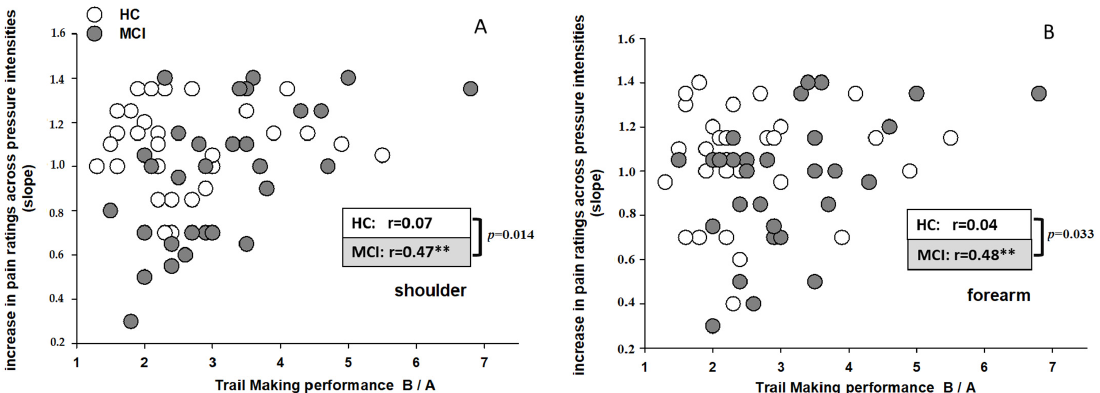
Figure 2. Associations between the escalation in pain perception across pressure stimuli (slope) and executive functioning (TMT-B/A) for the two stimulation sites ( A ). shoulder; ( B ). forearm). The different groups (HC, MCI) are displayed in different shades of grey. Partial correlation coefficients (r-values) are displayed separately for each group. Significant r-values are specified by ** ( p < 0.01). The p -values refer to the comparison of correlation coefficients between groups using z-statistics.